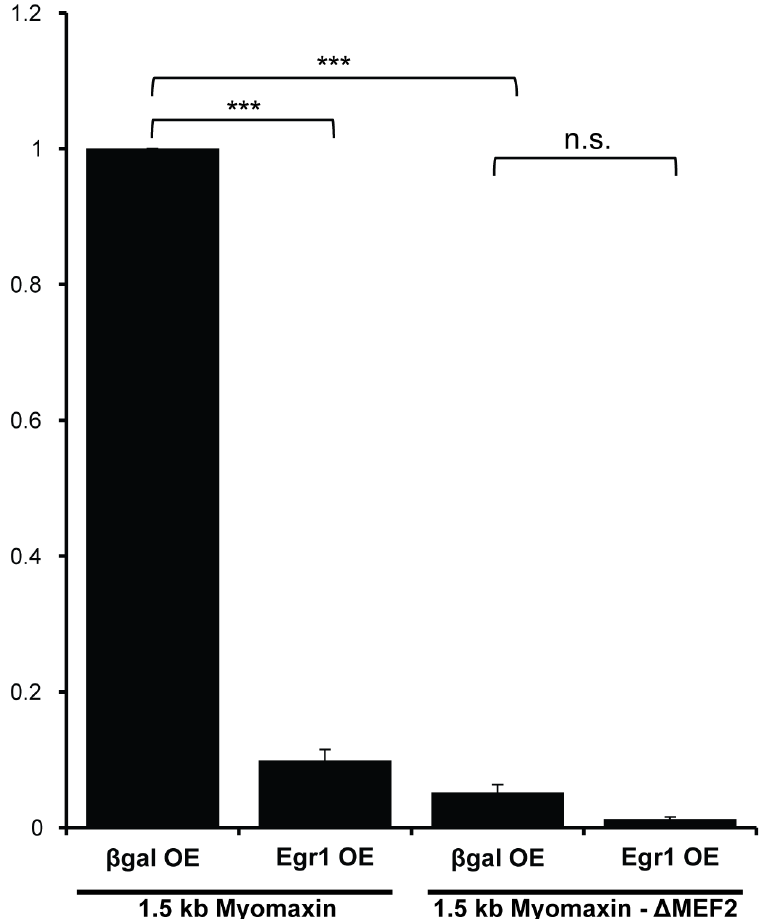
Fig 2. EGR1-mediated repression of endogenous MEF2 activity in cardiomyocytes is dependent on MEF2 DNA binding. Repression of MEF2-dependent costamere promoters by EGR1 requires intact MEF2 binding site. NRVMs were transduced with AdEGR1 and Ad β gal at an MOI of 25. Twenty four hours post- transduction, 1.5 kb myomaxin -Luc and 1.5 kb myomaxin Δ MEF2-Luc were transfected. Luciferase activity was measured 48 hrs after transfection. Firefly luciferase readings were normalized to Renilla luciferase readings. Data are mean ± SEM. *** p < 0.001, n.s. not